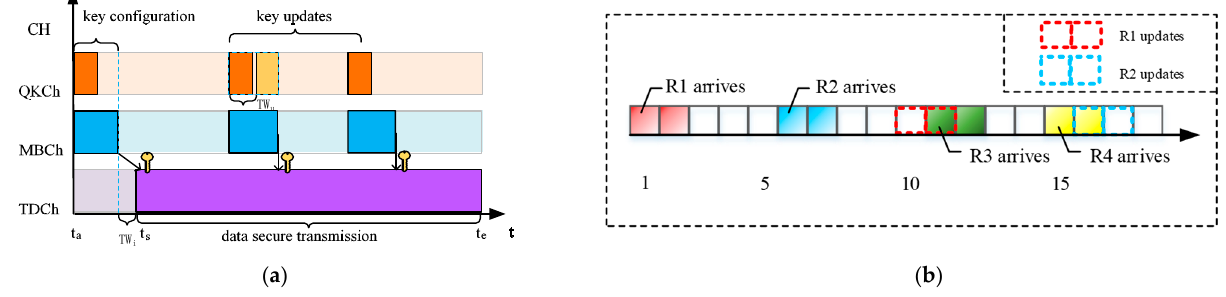
Figure 2. ( a ) Coordination of three kinds of channels; ( b ) Resource allocation conflicts in routing, wavelength, and timeslot allocation (RWTA).